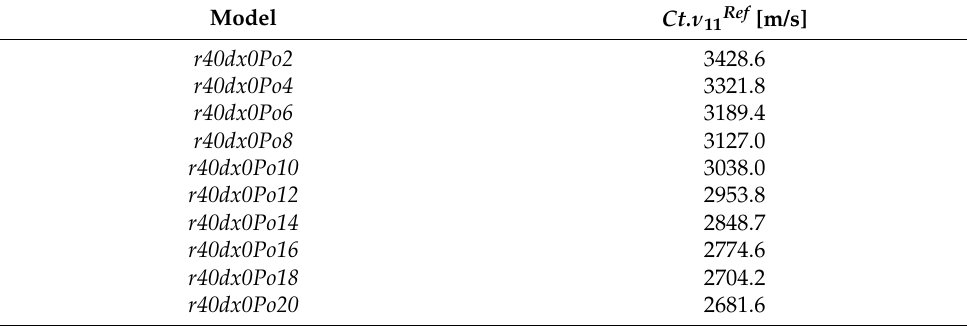
Table A3. Results of Ct.Th Ref and Ct. ν 11 Ref of transmission simulation.